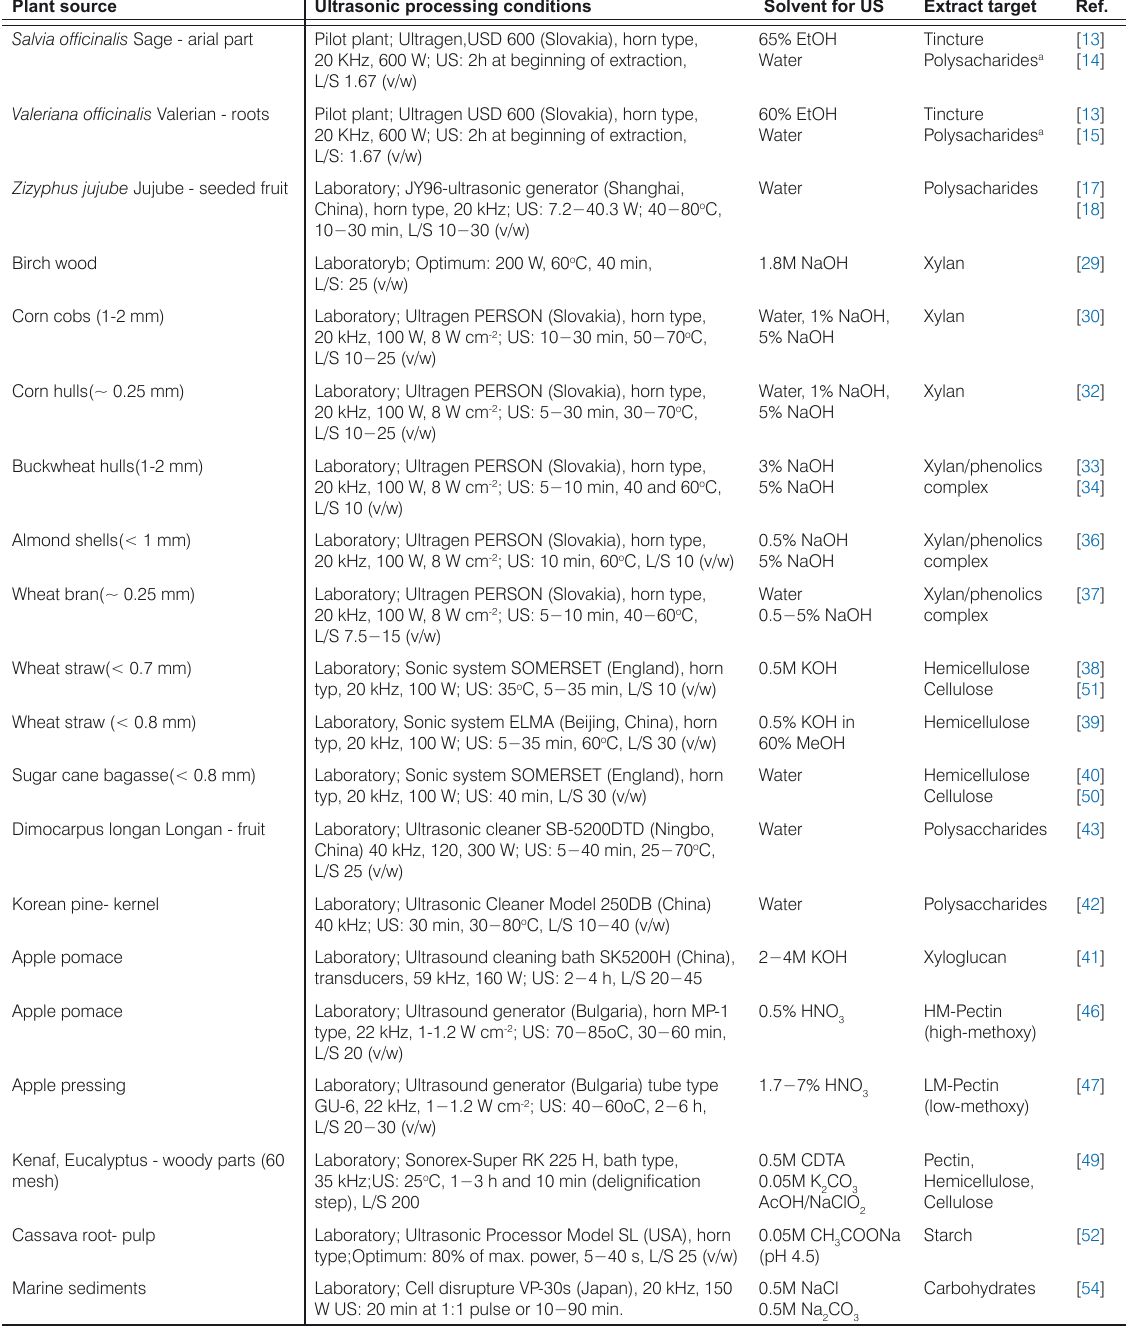
Table 1. Overview of plant sources and conditions of ultrasound-assisted extraction of